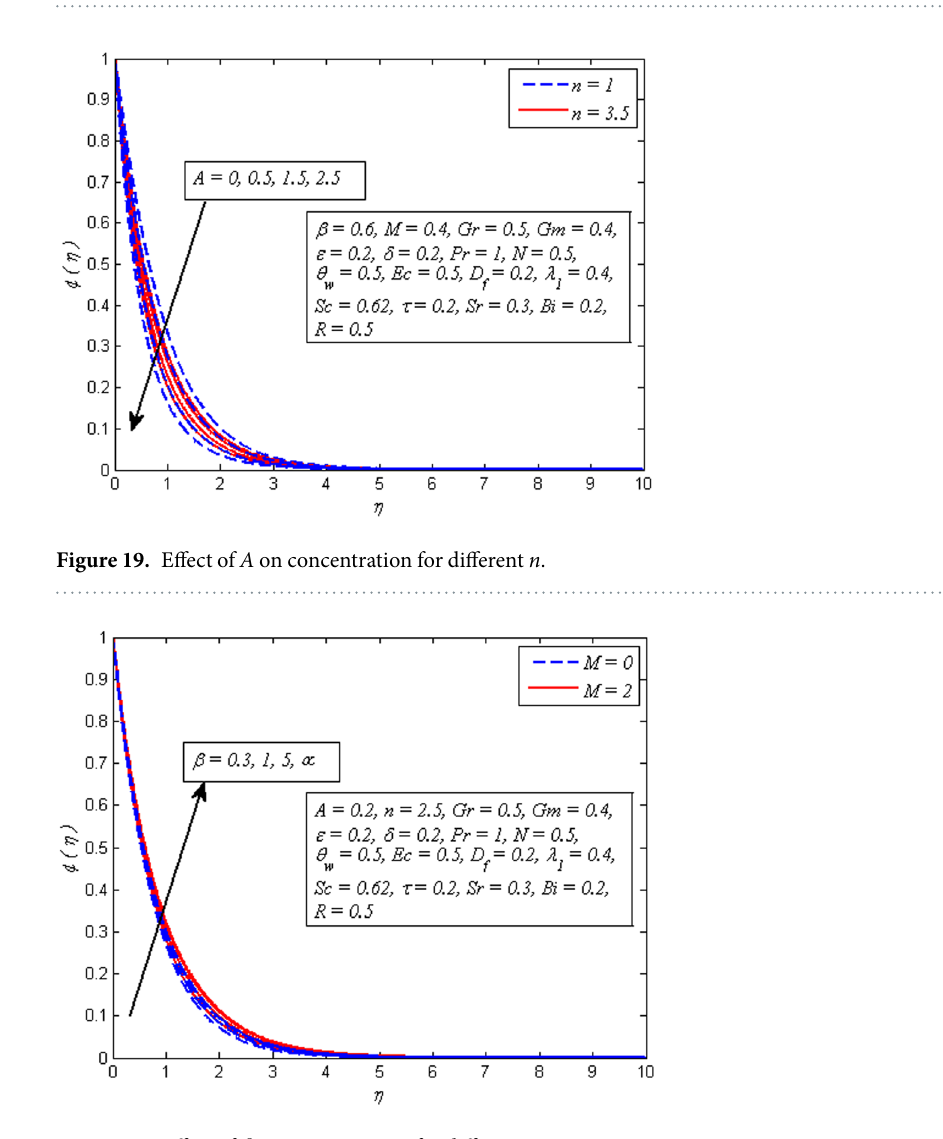
Figure 20. Effect of β on concentration for different M